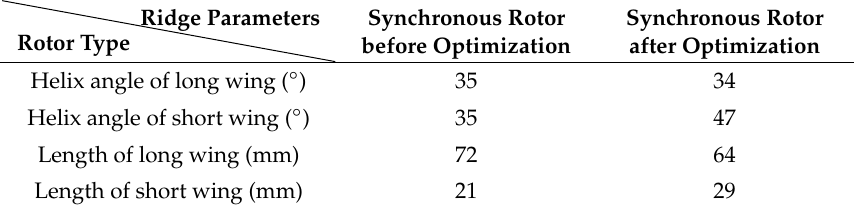
Table 4. Rotor geometric parameters before and after optimizing.